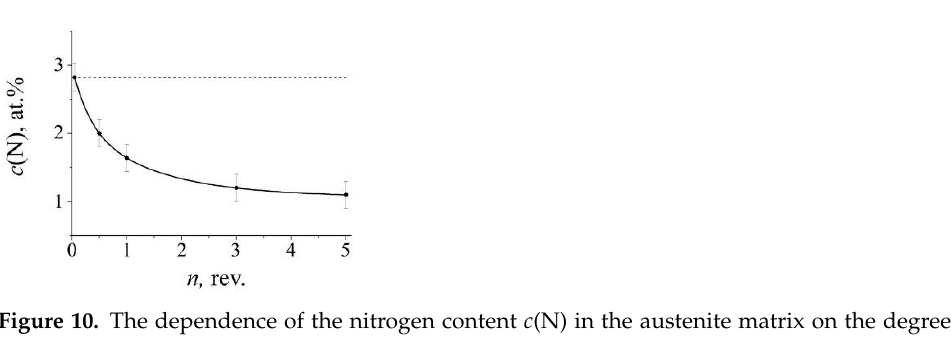
Figure 9. Mössbauer spectra and distributions p ( V ) of quenched FeMn 22 Cr 18 N 0.83 steel with a change in the degree of deformation n (number of revolutions n ) at HPT at 573 K. ( a ) — quenching; ( b ) — n = 0.5 rev.; ( c ) — n = 1 rev.; ( d ) — n = 3 rev.; ( e ) — n = 5 rev. The component of the “ nitrogenous ” doublet S D 1 is highlighted by darkening.